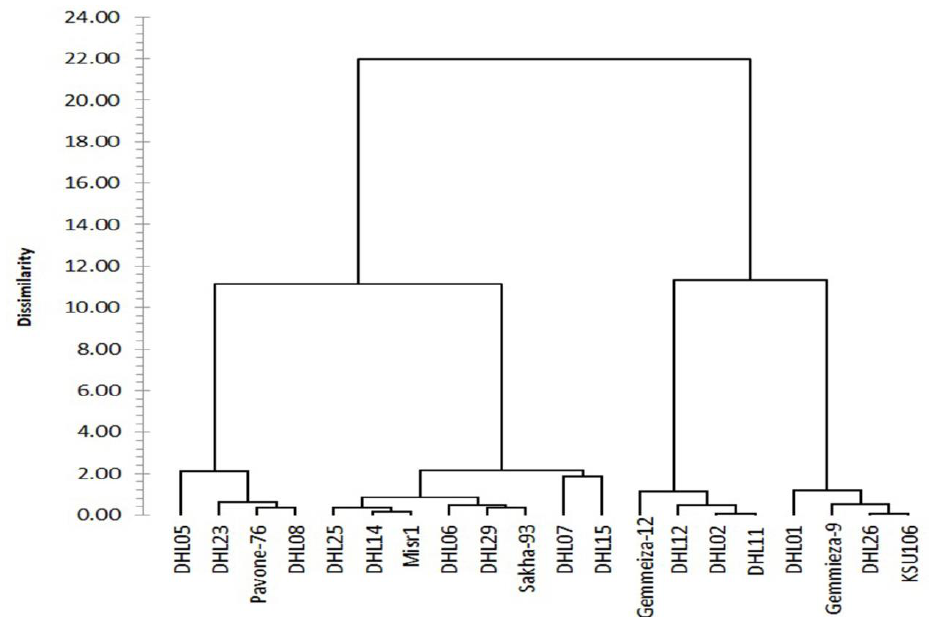
Figure 4. Dendrogram showing clustering of 20 wheat genotypes based on the Euclidean distance of four tolerance indices: GFD, CAT, SL, and GY.